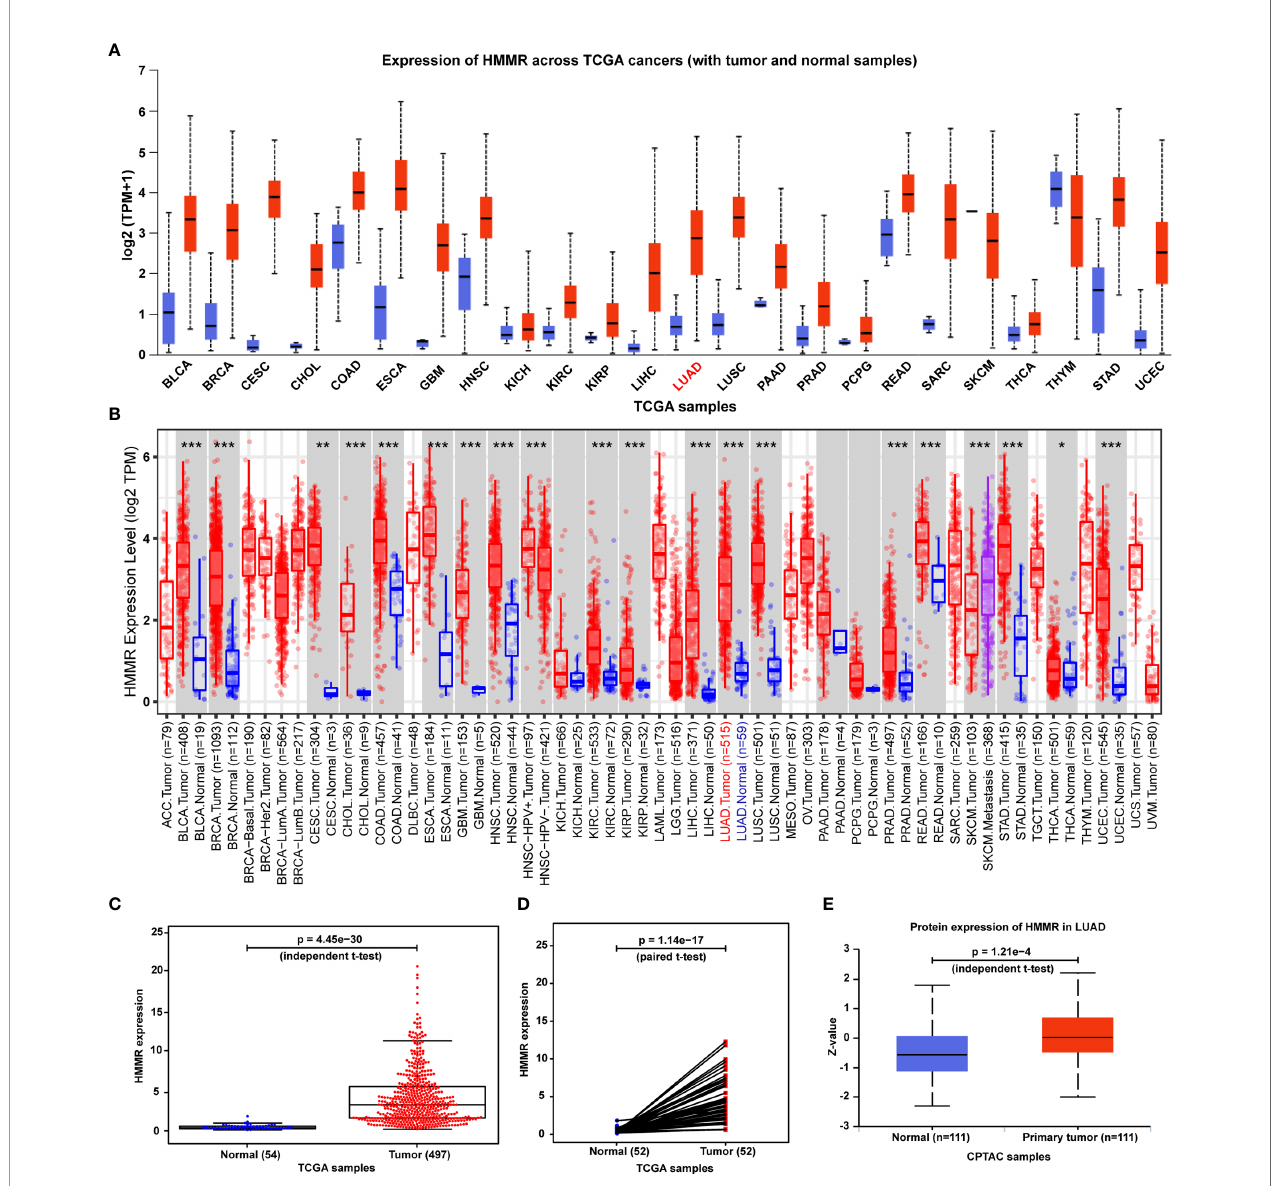
FIGURE 1 | HMMR expression in normal human tissues, human tumors, and LUAD. (A) HMMR mRNA expression between multiple human cancers and corresponding normal tissues in the UALCAN database. (B) HMMR expression level among a variety of human cancers in the TIMER database (* p < 0.05, ** p < 0.01, *** p < 0.001). (C) HMMR mRNA expression between tumors and normal tissues of LUAD patients from the TCGA database. (D) HMMR mRNA expression between pairs of tumors and normal tissues of LUAD patients from the TCGA database. (E) HMMR protein expression between primary tumors and normal tissues of LUAD patients from the CPTAC